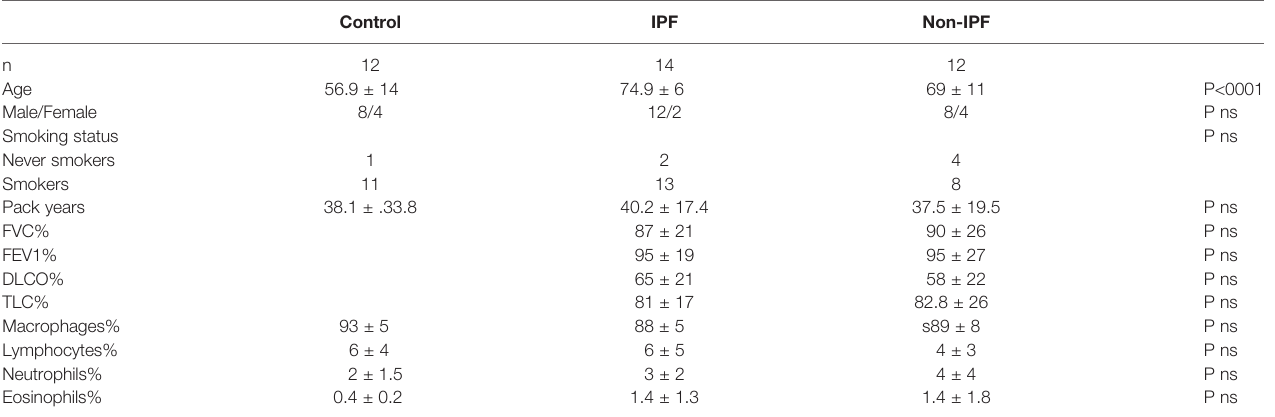
TABLE 1 | Patient